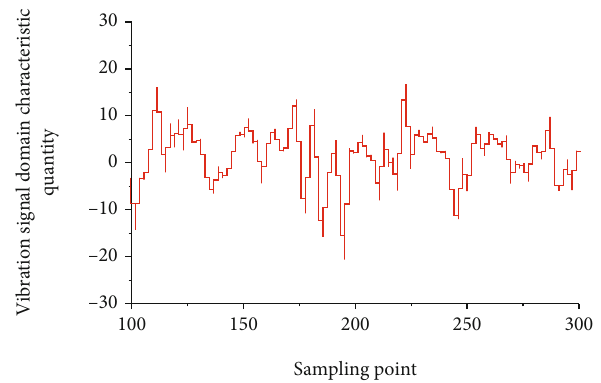
Figure 4: Time-domain characteristic quantity curve of vibration